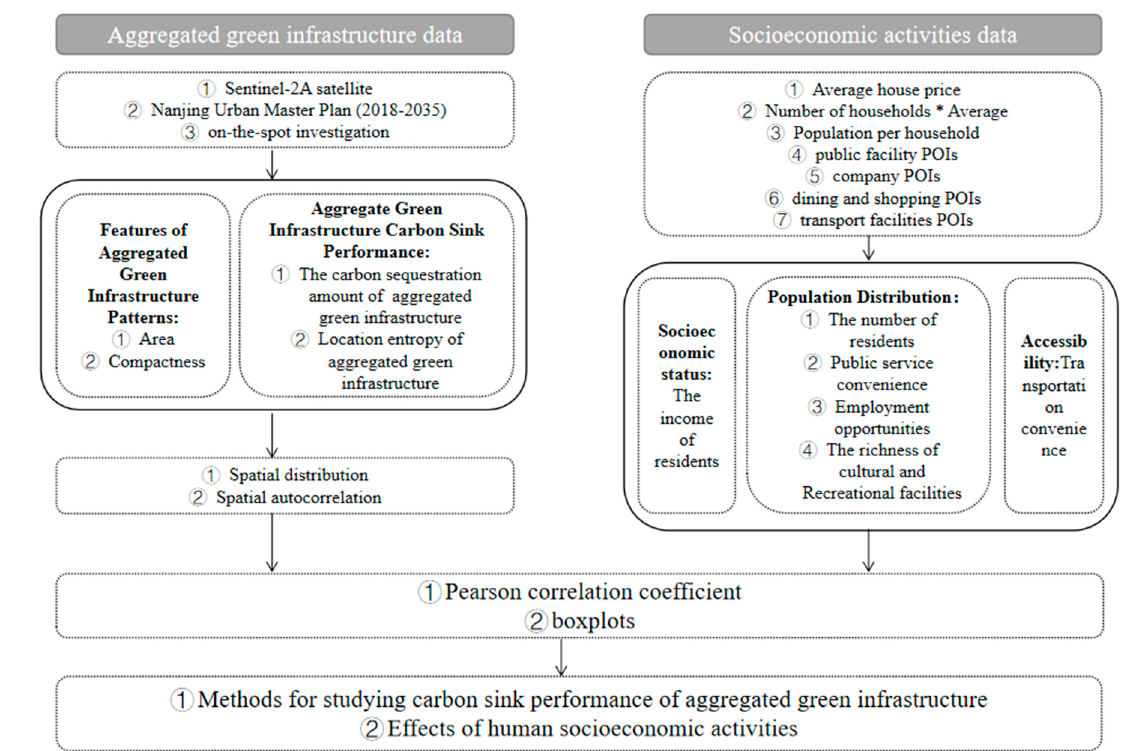
Figure 2. Experimental method step diagram.